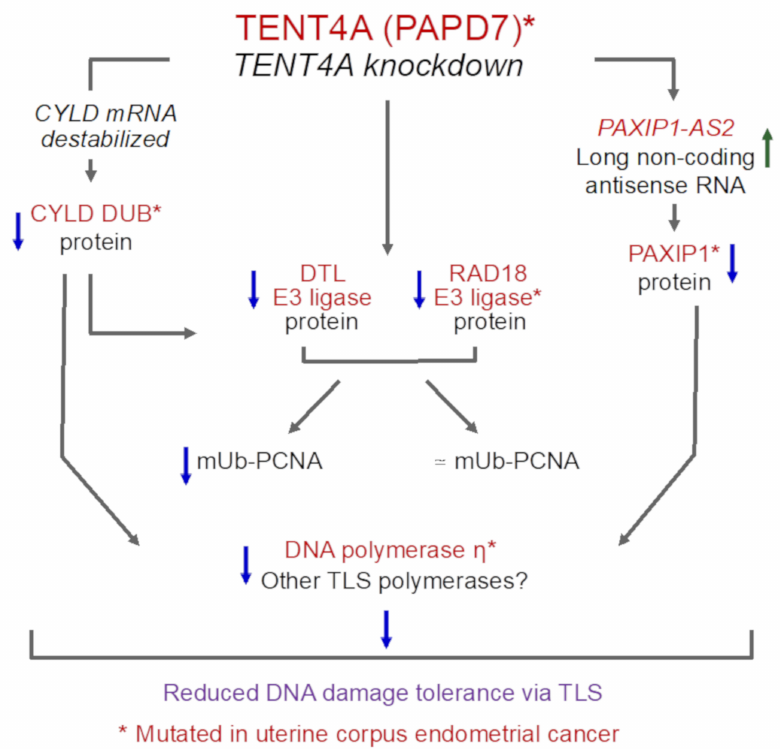
Figure 9. A scheme representing the three branches of regulation of TLS by TENT4A. See text for